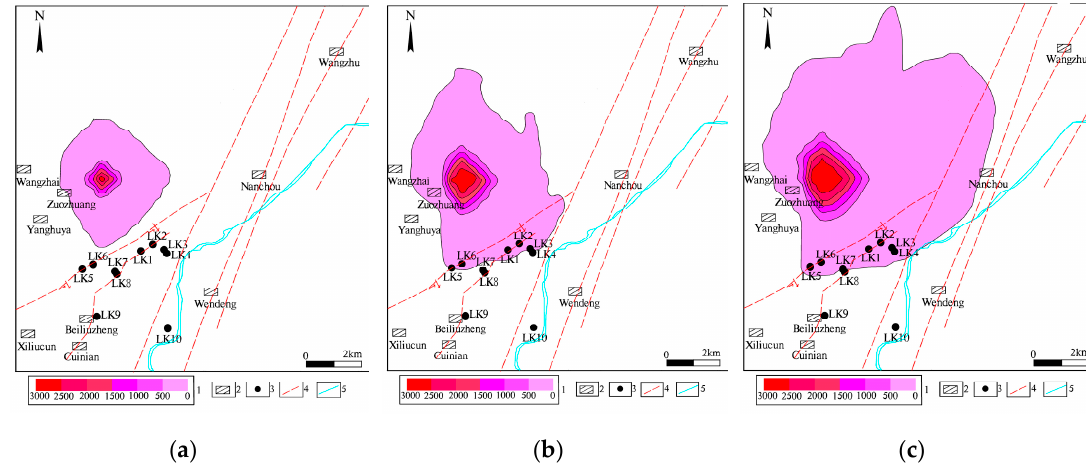
Figure 5. Plane range of solute migration. ( a ) 10 years, ( b ) 30 years, ( c ) 50 years; 1: Concentration of Cl − (mg/L); 2: Village; 3: Liuzheng water source mining well; 4: Fault; 5: River.